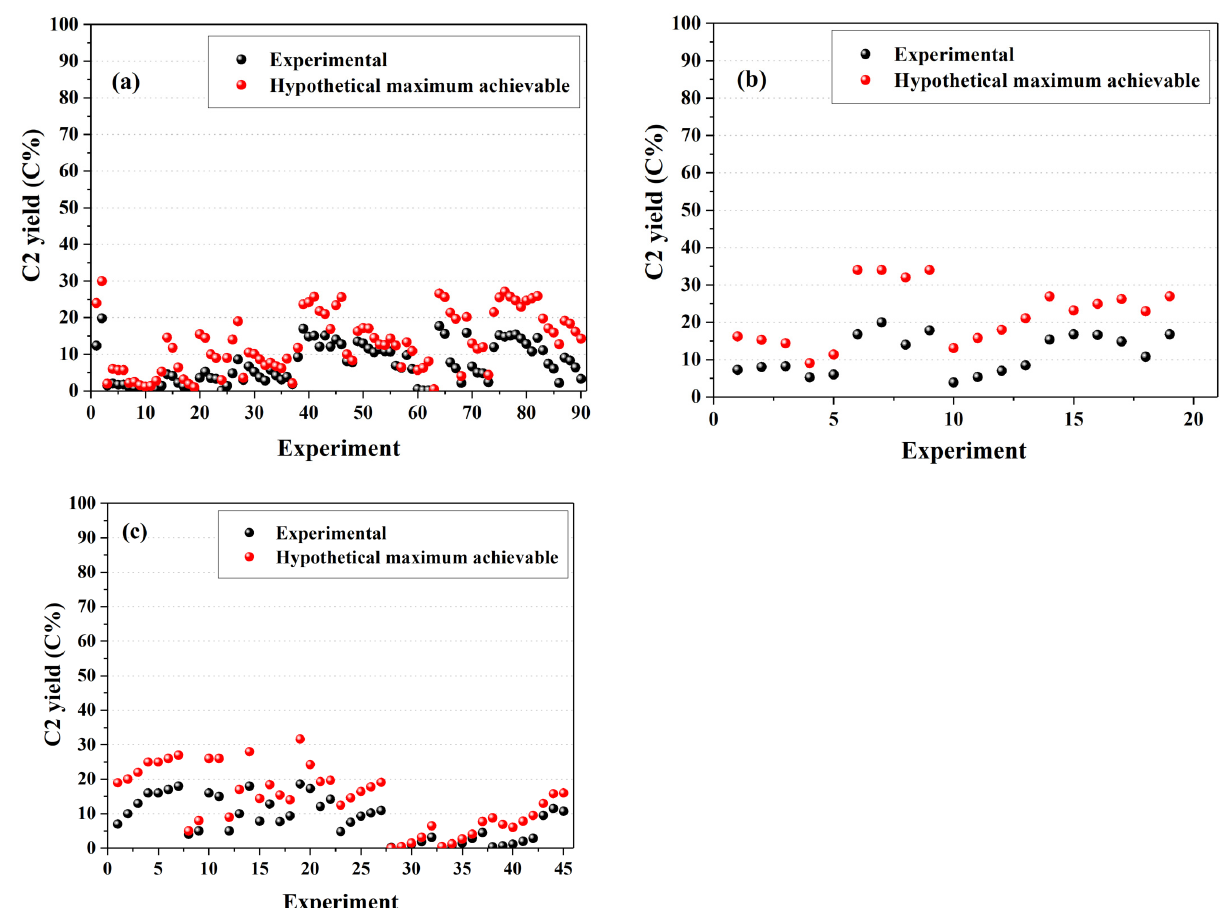
Figure 33. Comparison between experimental C2 yield and hypothetical maximum C2 achievable yield (in the absence of CO and CO 2 and at the same level of experimental methane conversion) for bimetallic oxides: ( a ) promoted or supported alkaline earth metal oxides, ( b ) involving lanthanoids metal oxides, and ( c ) transition or post-transition metal oxides.